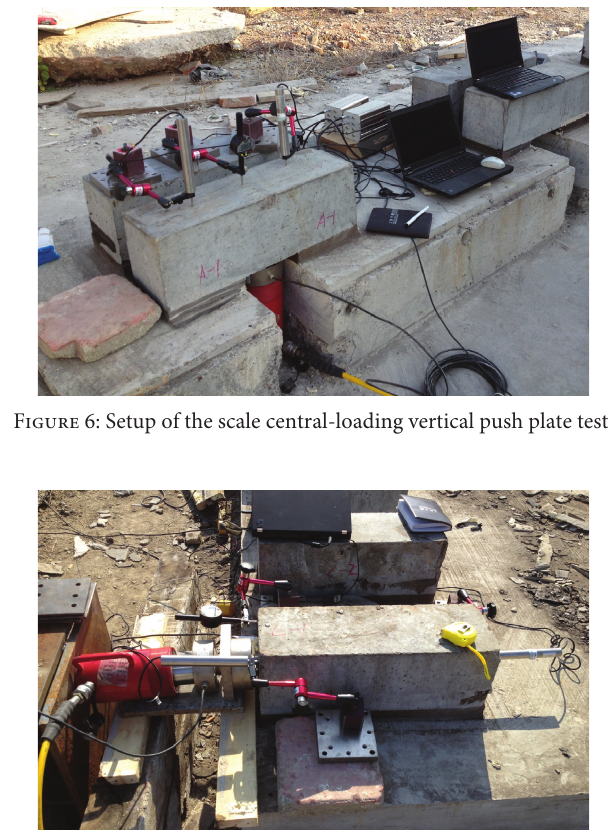
Figure 9: Force-displacement curve of the horizontal push plate test.